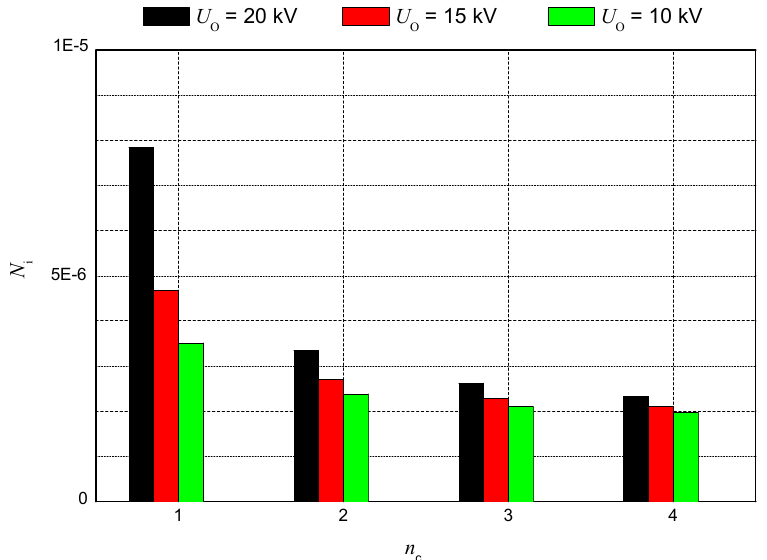
Figure 13. Frequency of damage N I to apparatus as a function of the withstand voltage U W of apparatus for LV circuits in conduit. Figure 12. Frequency of damage N I to apparatus as a function of the number n c of connected LV circuits in multipolar cable.